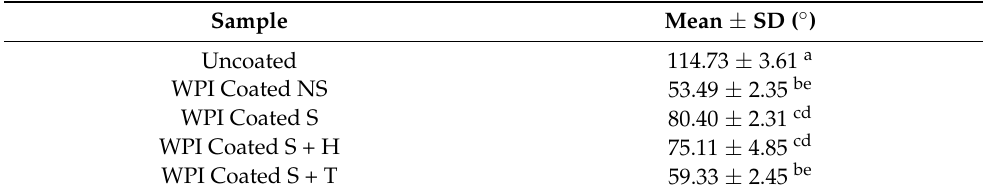
Table 2. Water-Contact angle test results on Ti6Al4V uncoated and coated in different conditions. Results are expressed as mean ± standard deviation (SD). Means without a common superscript differ ( p <